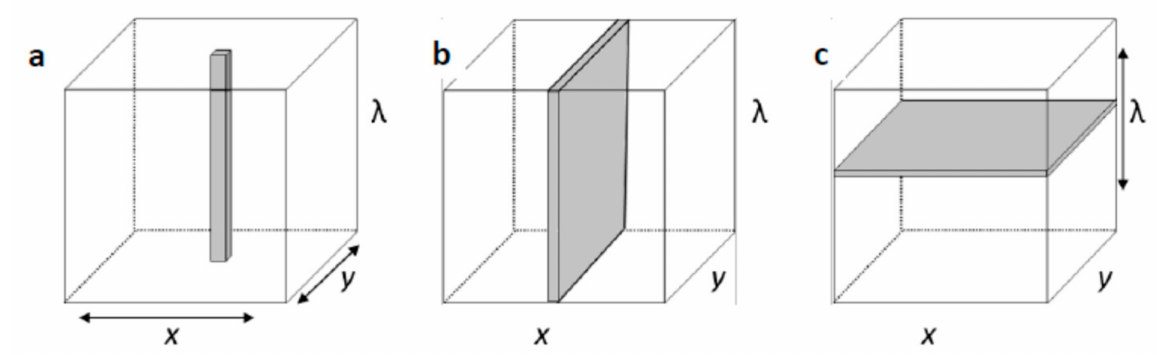
Figure 4. Three configurations of hyperspectral imaging systems. ( a ) Whiskbroom or point scan configuration—scans the sample in point form. ( b ) Push-broom or line-scan configuration—scans the sample in consecutive lines. ( c ) Staredown configuration—scans entire sample (within camera frame) one wavelength at a time [88]. Reprinted with permission from ref. [88]. Copyright 2013